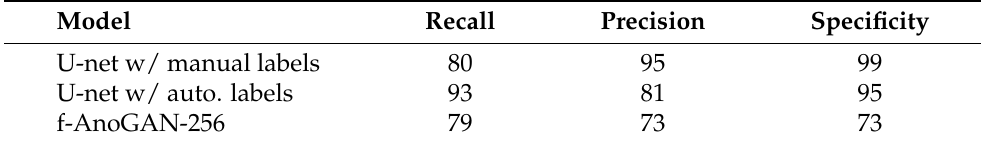
Table 6. Image-level results from U-net trained on manually created labels and U-net trained on automatically created labels, as well as the results from the anomaly model used for